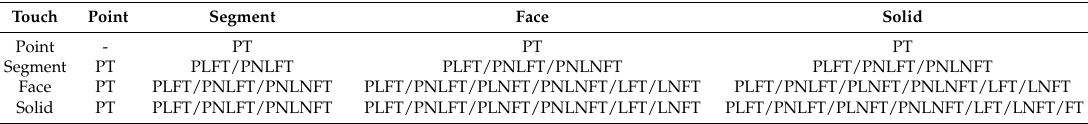
Table 5. The touch topological relation for objects in a 3-D